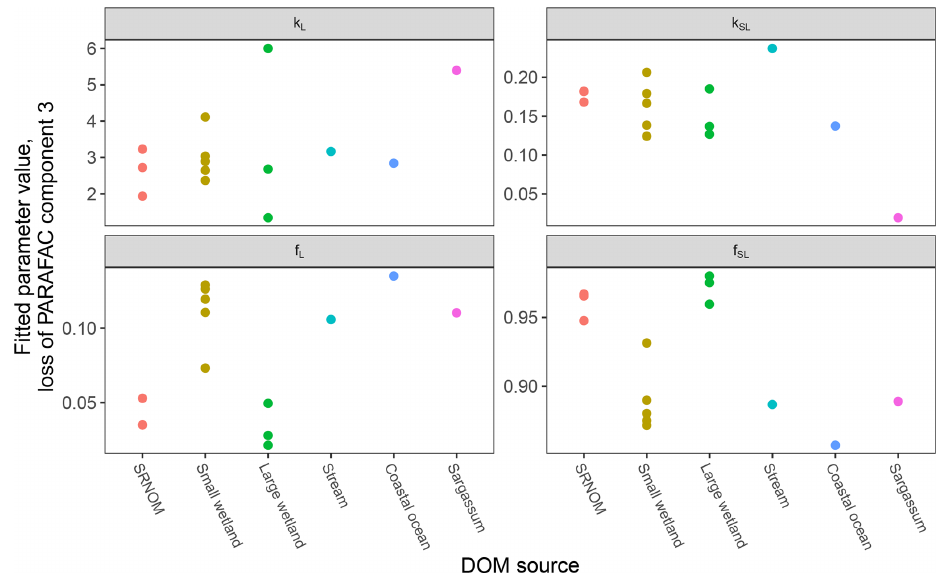
Figure A2. Fitted biexponential model parameters (Eq. 3) from the time series of PARAFAC component three (see Fig. 9 for data). f is unitless, and k is m 2 [molphotons] − 1 . For wetland samples, shapes represent different sampling dates (circles are 4 October 2017, triangles are 20 December 2017, and squares are 1 April